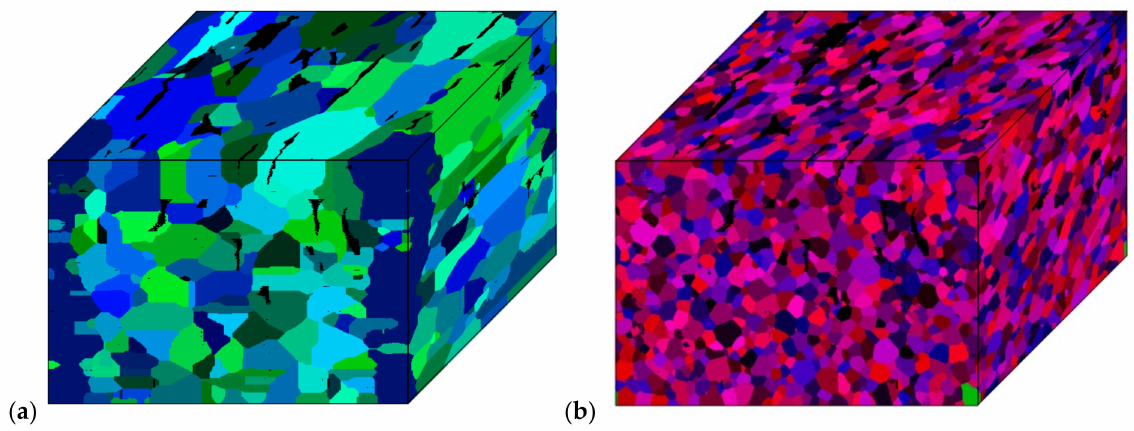
Figure 10. 3D visualization of ( a ) initial unrecrystallized and ( b ) final recrystallized